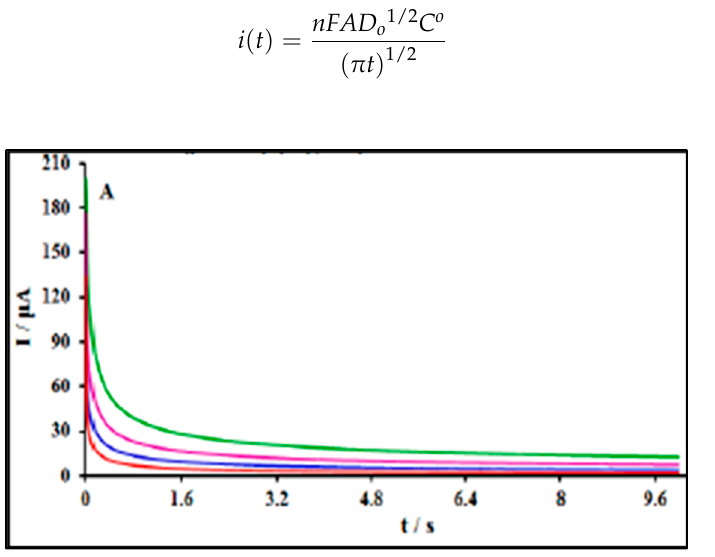
Figure 8. Chronoamperograms of different concentrations of an analyte (Adapted from [111]).